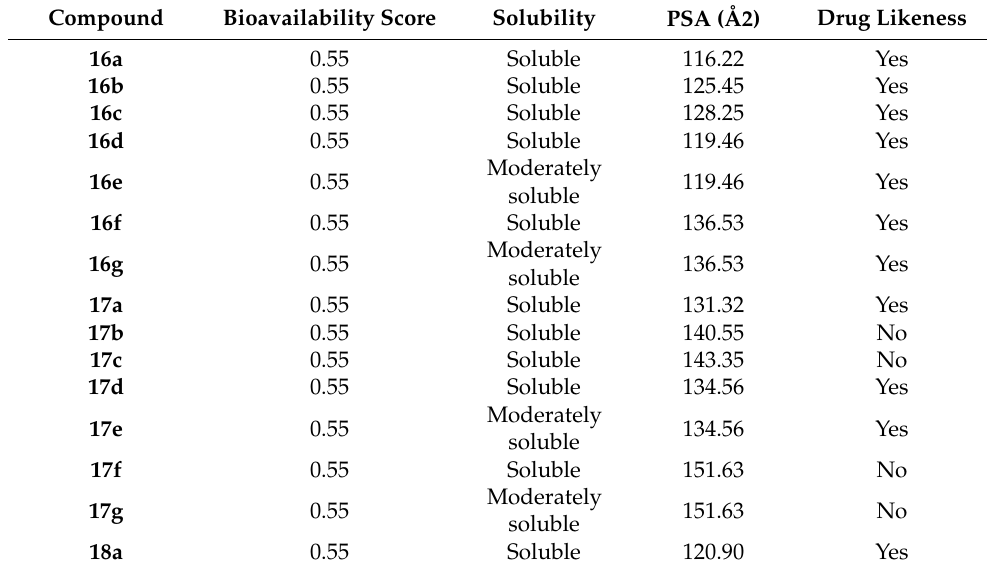
Table 4. Swiss ADME pharmacokinetics prediction for the compounds (data were obtained from http://www.swissadme.ch (accessed on 28 November